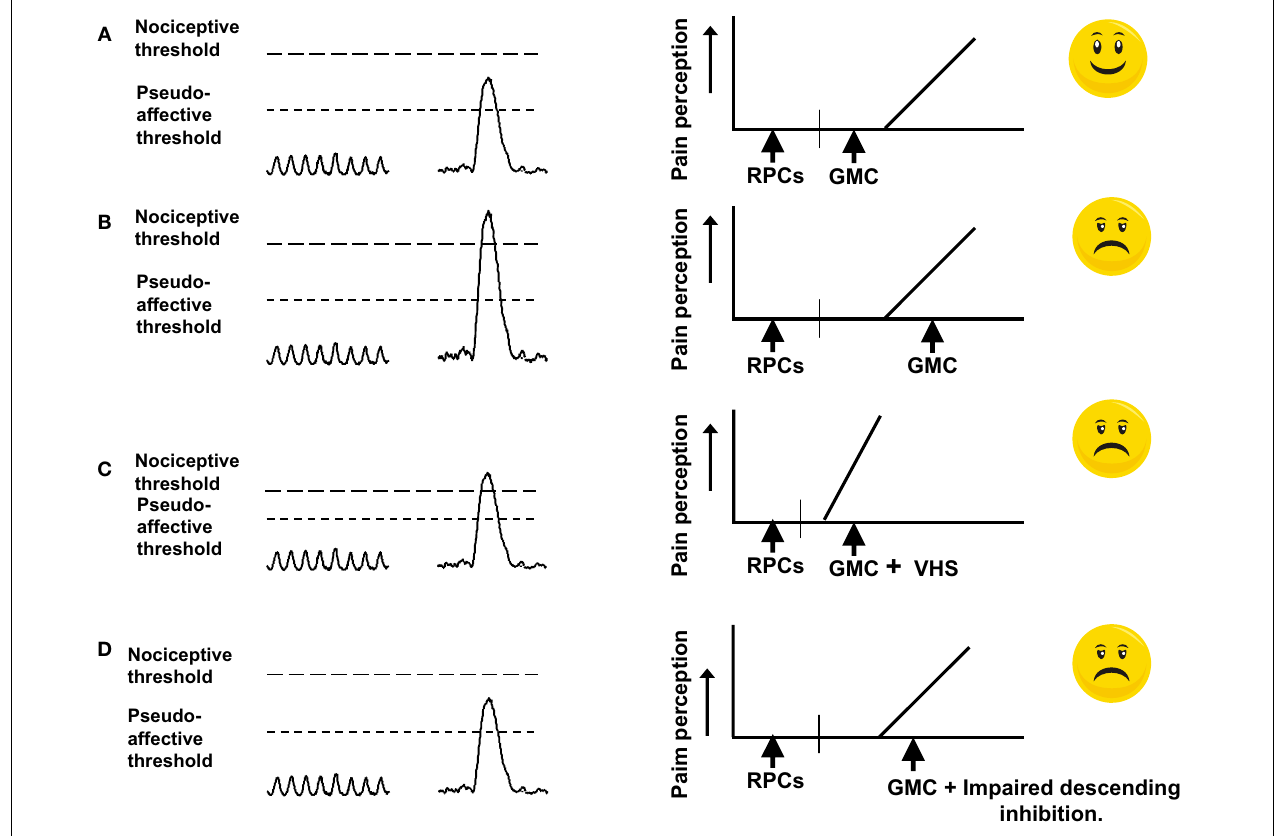
results. (C) Visceral hypersensitivity of the afferent neurons or impaired processing of signals in the CNS effectively lowers the nociceptive threshold so that the afferent signal generated by a GMC of normal amplitude exceeds the threshold for perception of pain. (D) Due to impairment of descending inhibition, the receiving segment generates tone and sends afferent signals. These signals add to those generated by the GMC.The combined signal exceeds the nociceptive threshold to induce the sensation of pain (Reproduced with permission from Sarna,